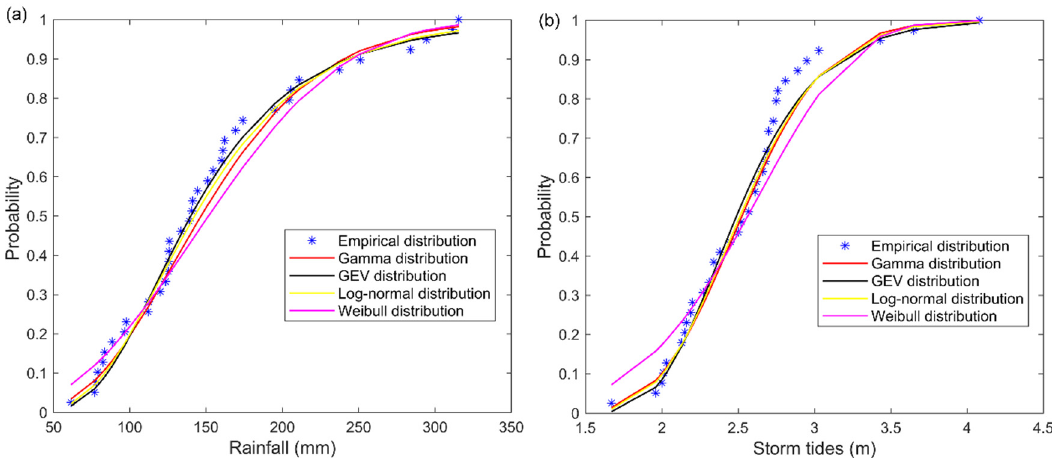
Figure 5. The empirical distribution and four marginal distributions of ( a ) rainfall, ( b ) storm tides. Table 3. Estimated values of marginal distribution parameters.